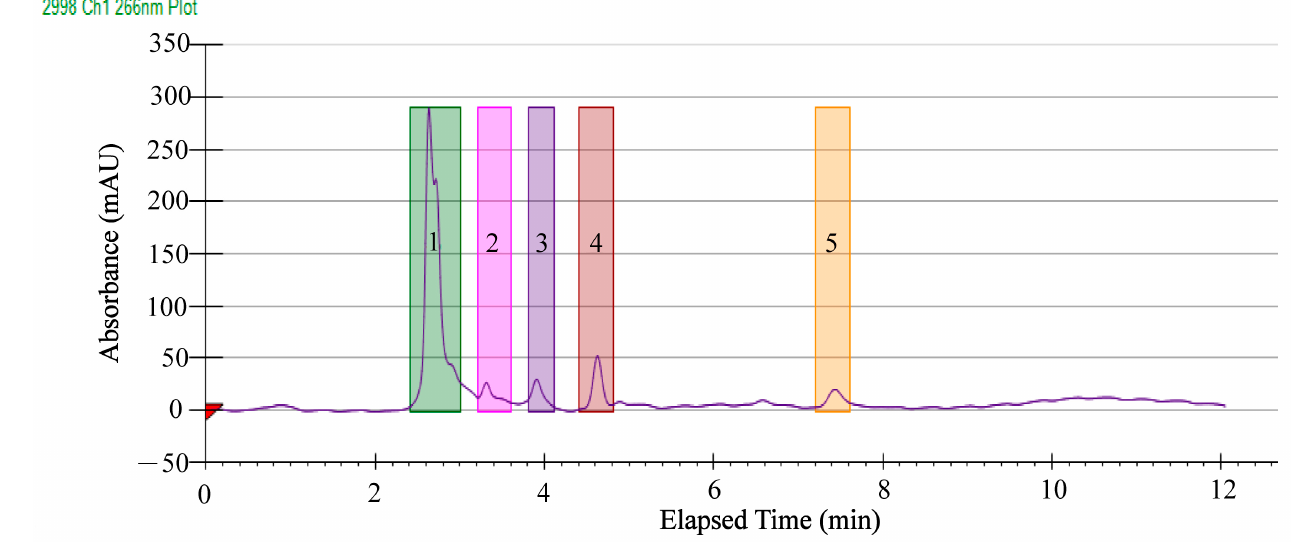
Figure 7. The Prep-HPLC diagram of purifying the GMPE.